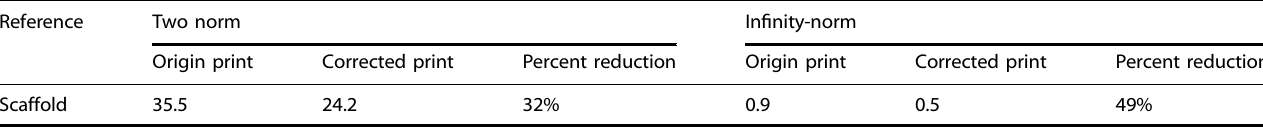
Table 2. The results of the two norm schemes to correct the bone scaffold path 40